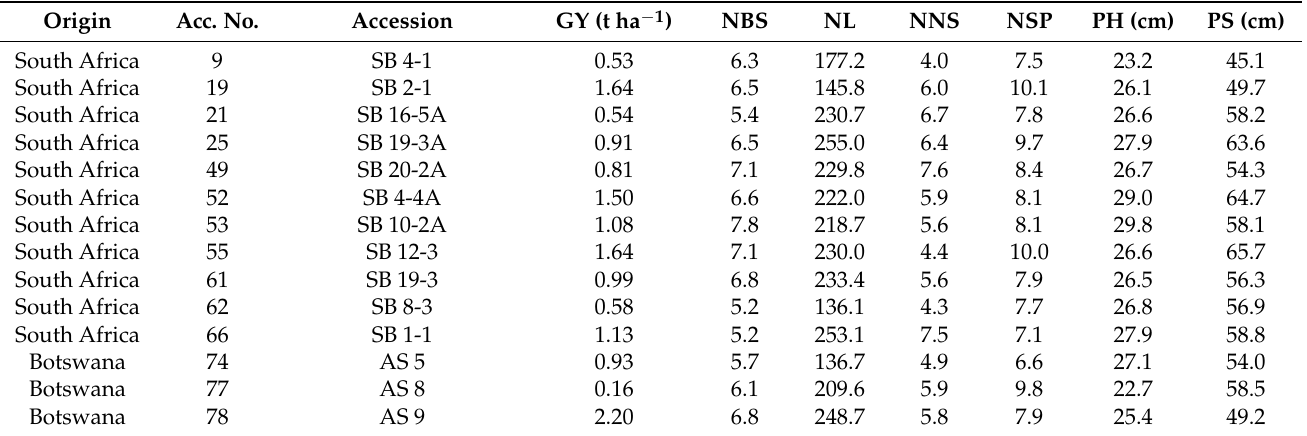
Table 3. Means of combined analysis of grain yield and yield components of bambara